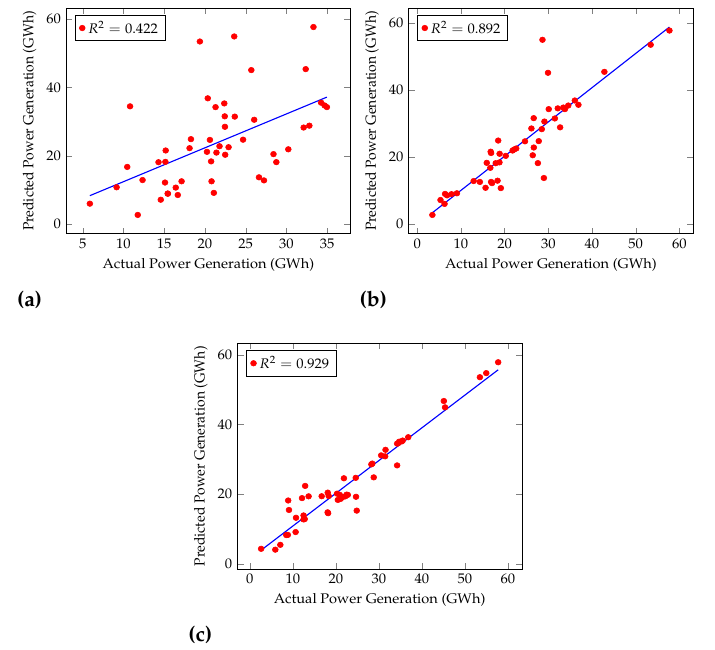
Figure 6. Cascaded ANFIS behavior for different levels. ( a ) Level 1, ( b ) level 10, ( c ) level 20. VersionApril1,2022submittedto Sensors